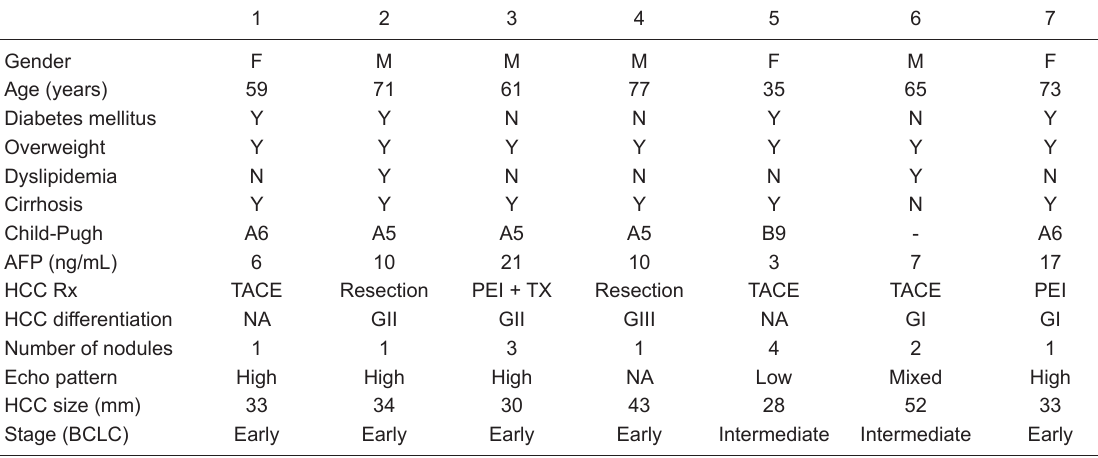
Table 1. Demographic, clinical, biochemical, and histological parameters of the 7 patients